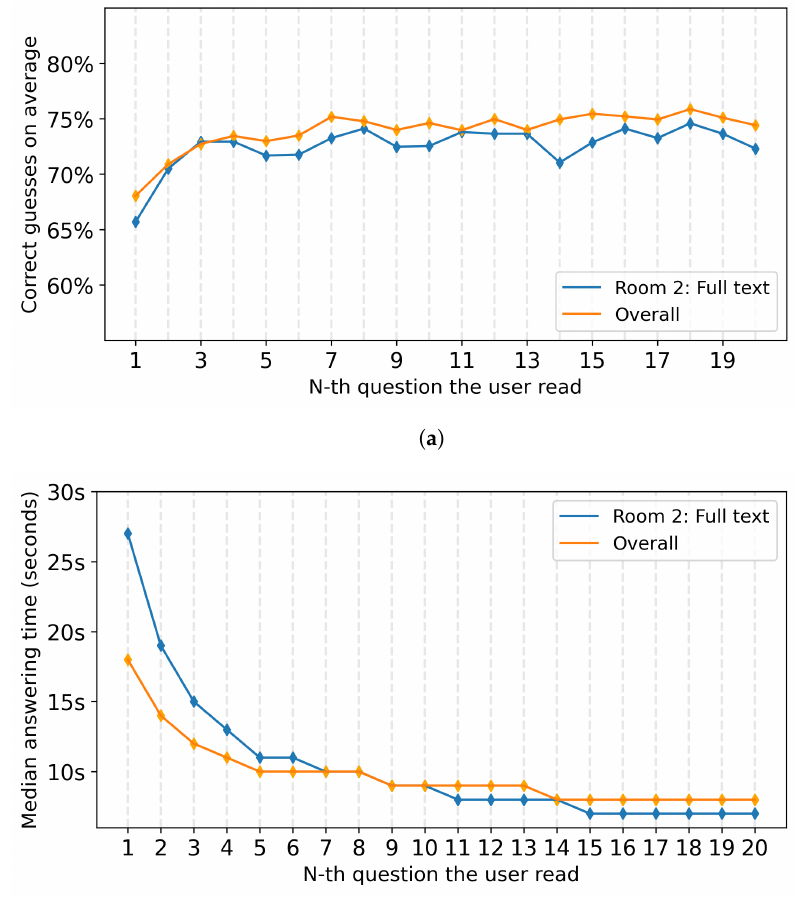
Figure 9. Average accuracy ( a ) and median answering times ( b ) of users for questions in order of presentation to the users. Values in Room 2 are compared to their corresponding values in all the rooms taken altogether. ( a ) Accuracy in Room 2 does not drop progressively. However, it is constantly lower than overall accuracy. ( b ) Users in Room 2 start reading the full text on the first questions, but they get quickly annoyed, and the reading time falls shortly. During the second half of the test, Room 2 users answer even more rapidly than in the other